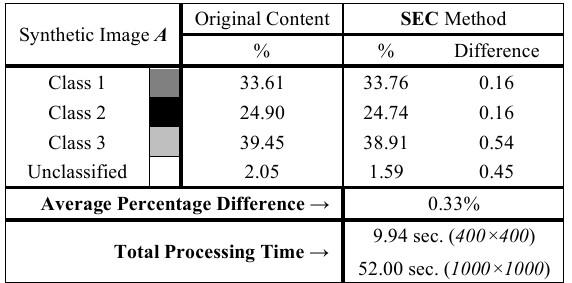
Table 2. Comparative table of the class percentages obtained by the SEC method for the synthetic image A Synthetic Image B